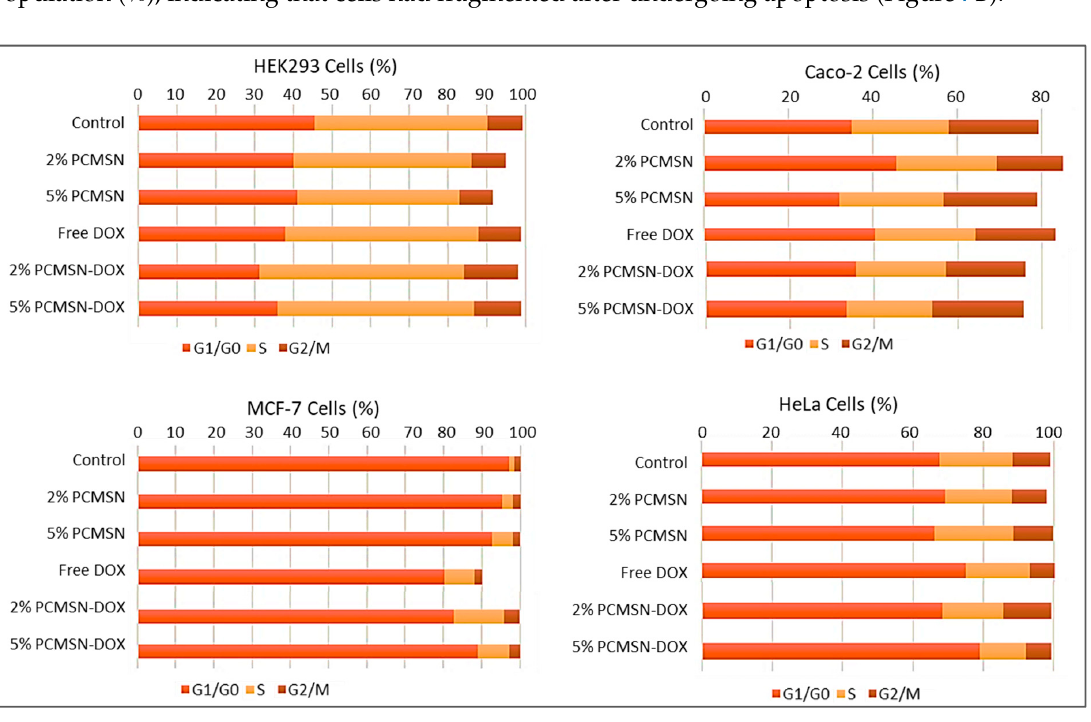
Figure 8. Apoptotic indices calculated from fluorescent micrographs taken of each cell line treated with MSNs, drug and DOX-loaded MSNs.